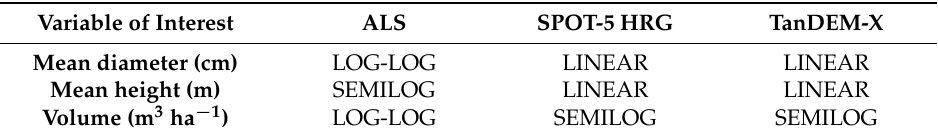
Table 3. Regression model forms used in this